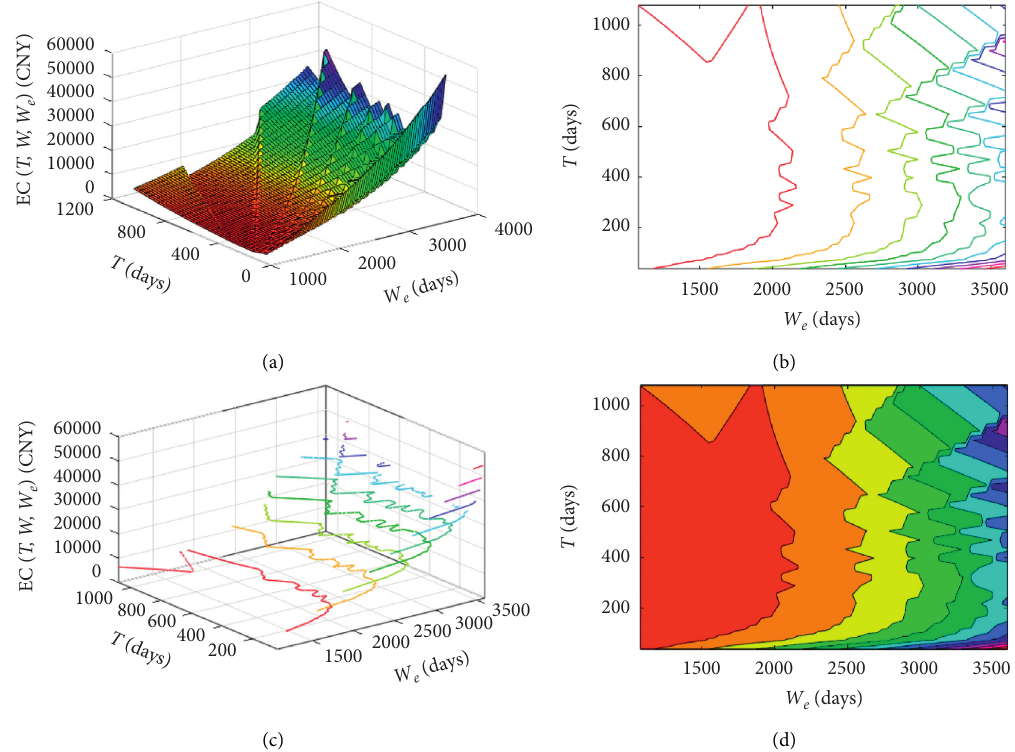
Figure 5: Change trend of system EW cost. (a) 3D change trend of system extended warranty cost. (b) 2D contour curves. (c) 3D contour curves. (d) 2D contour curves filled with color.